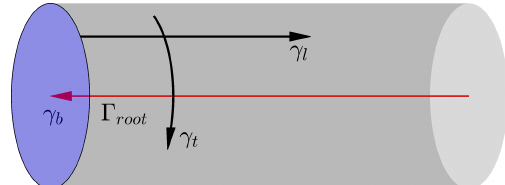
Figure 2. Illustration of different components of a right vortex cylinder. The bound vortex disc (in blue) with radial vorticity γ b , the vortex cylinder (in gray) with longitudinal γ l and tangential γ t trailed vortex components, and a root vortex (cid:48) root (in